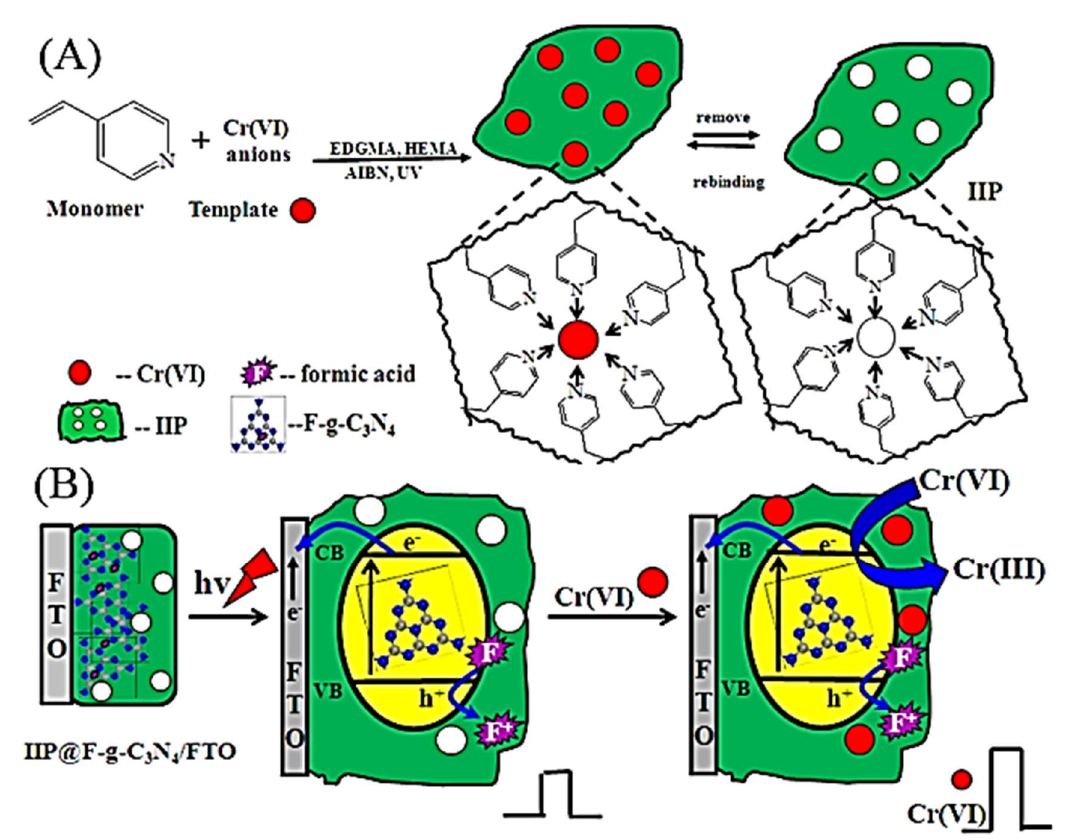
Figure 5. Schematic illustration of the formation process of ( A ) the IIP and ( B ) the principle of PEC determination of Cr (VI) using IIP@ graphitic carbon nitride (F-g-C 3 N 4 ) [53]. (Reproduced under permission from Elsevier, doi:10.1016/j.jhazmat.2016.03.046).